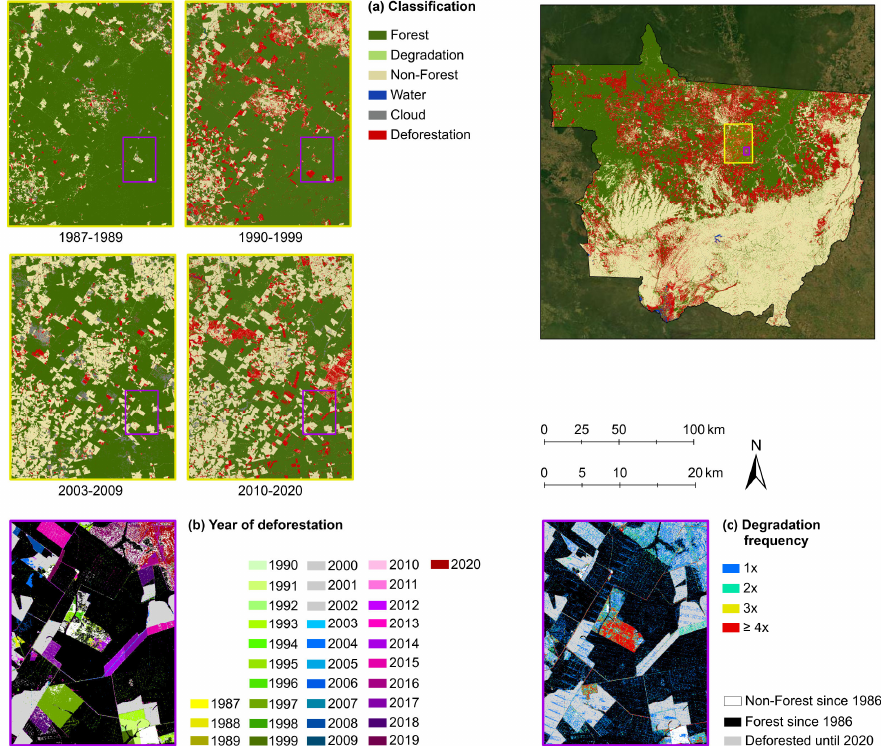
Figure 10. Annual deforestation and forest degradation from 1987 to 2020: ( a ) mapping of defor- estation within four decades; ( b ) annual deforestation visualized by year; ( c ) forest degradation frequencies (data basis: [54]. Service Layer Credits: Earthstar